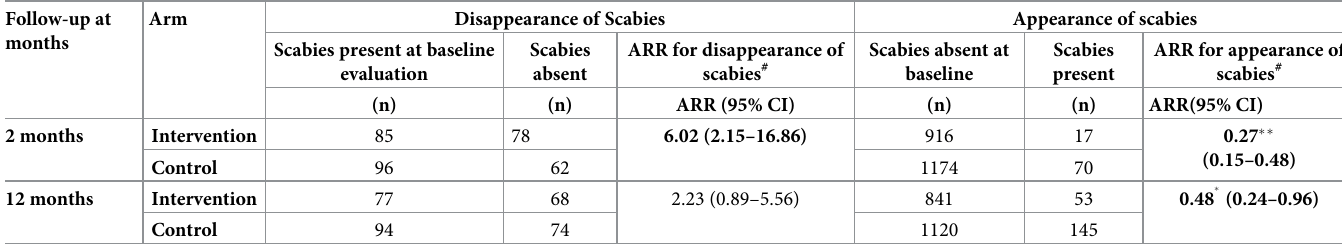
Table 3. Disappearance and appearance of scabies in the intervention and control arms at 2 and 12 month follow-up. Follow-up at